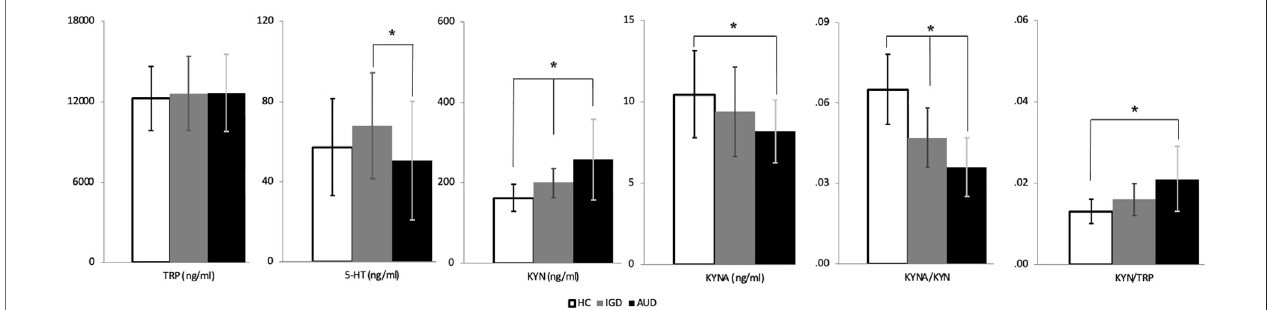
FIGURE 3 | Kynurenine pathway metabolites in the alcohol use disorder, Internet gaming disorder, and healthy control groups. TRP, Tryptophan; 5-HT, 5- hydroxytryptamine; KYN, Kynurenine; KYNA, Kynurenic acid. *p < 0.05.